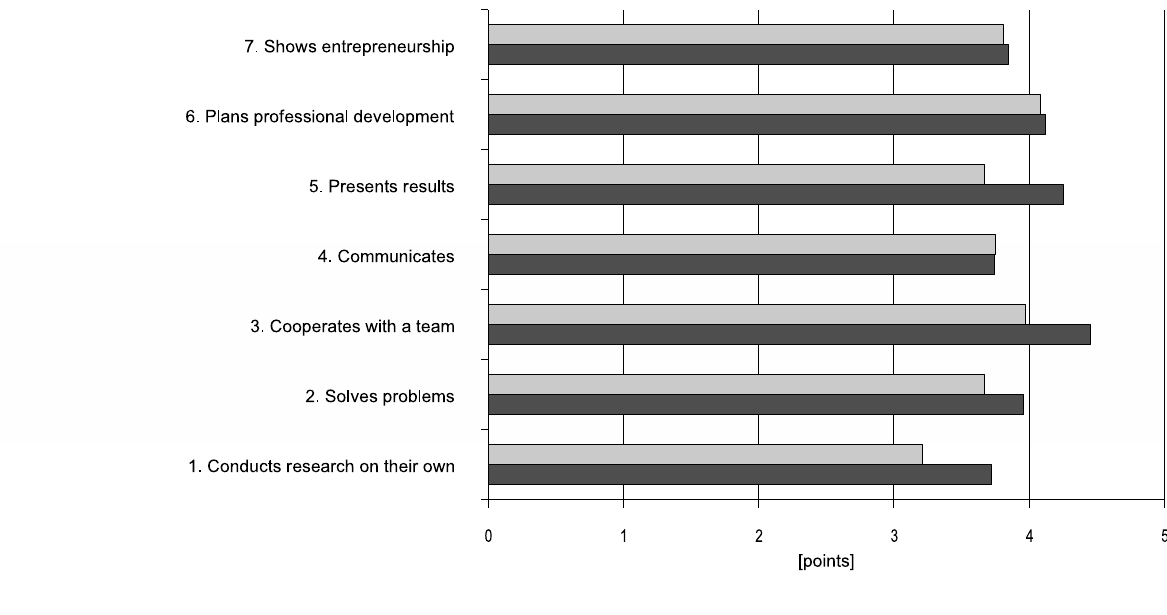
Fig. 2. Assessment of the level of didactic competencies of students of the last year of master’s